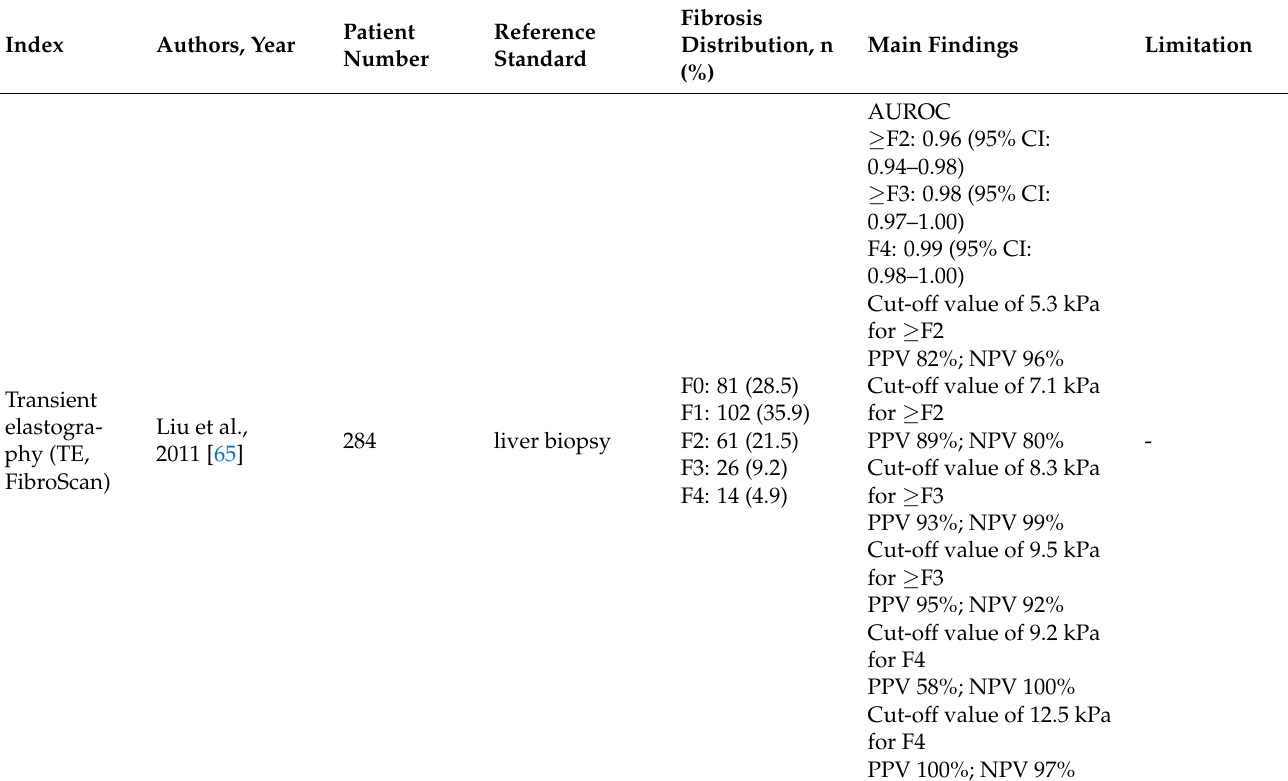
Table 3. Summary of radiological index to predict hepatic fibrosis in hemodialysis patients with HCV